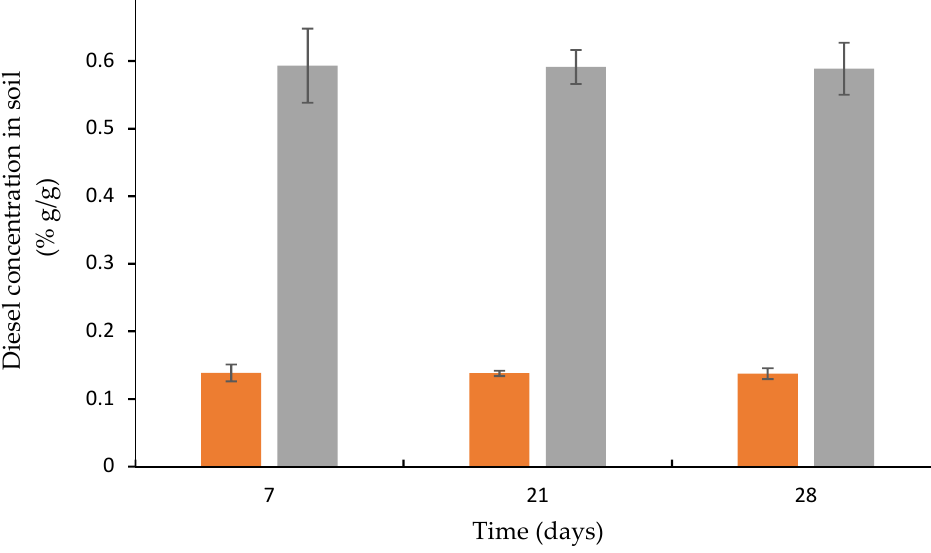
Figure 3. Diesel concentration in artificially contaminated soil: 0.15% (orange) and 0.6% (blue), % (g/g).